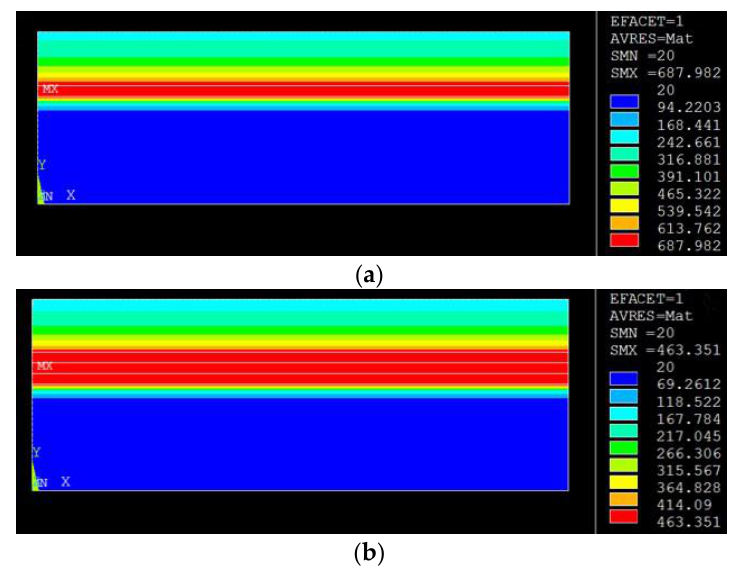
Figure 5. Results of the temperature field of the different composite ceramic panels: ( a ) with a single magnetic interlayer; ( b ) with a three-layer gradient.